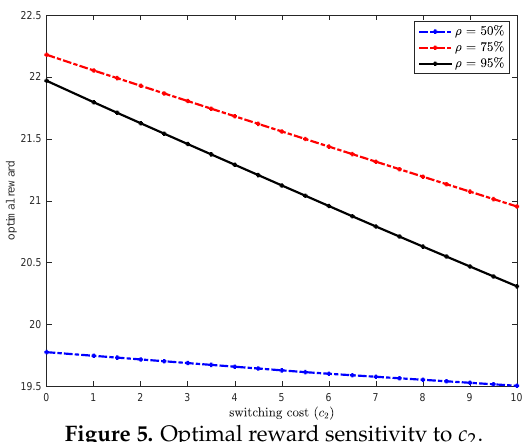
Figure 5. Optimal reward sensitivity to c 2